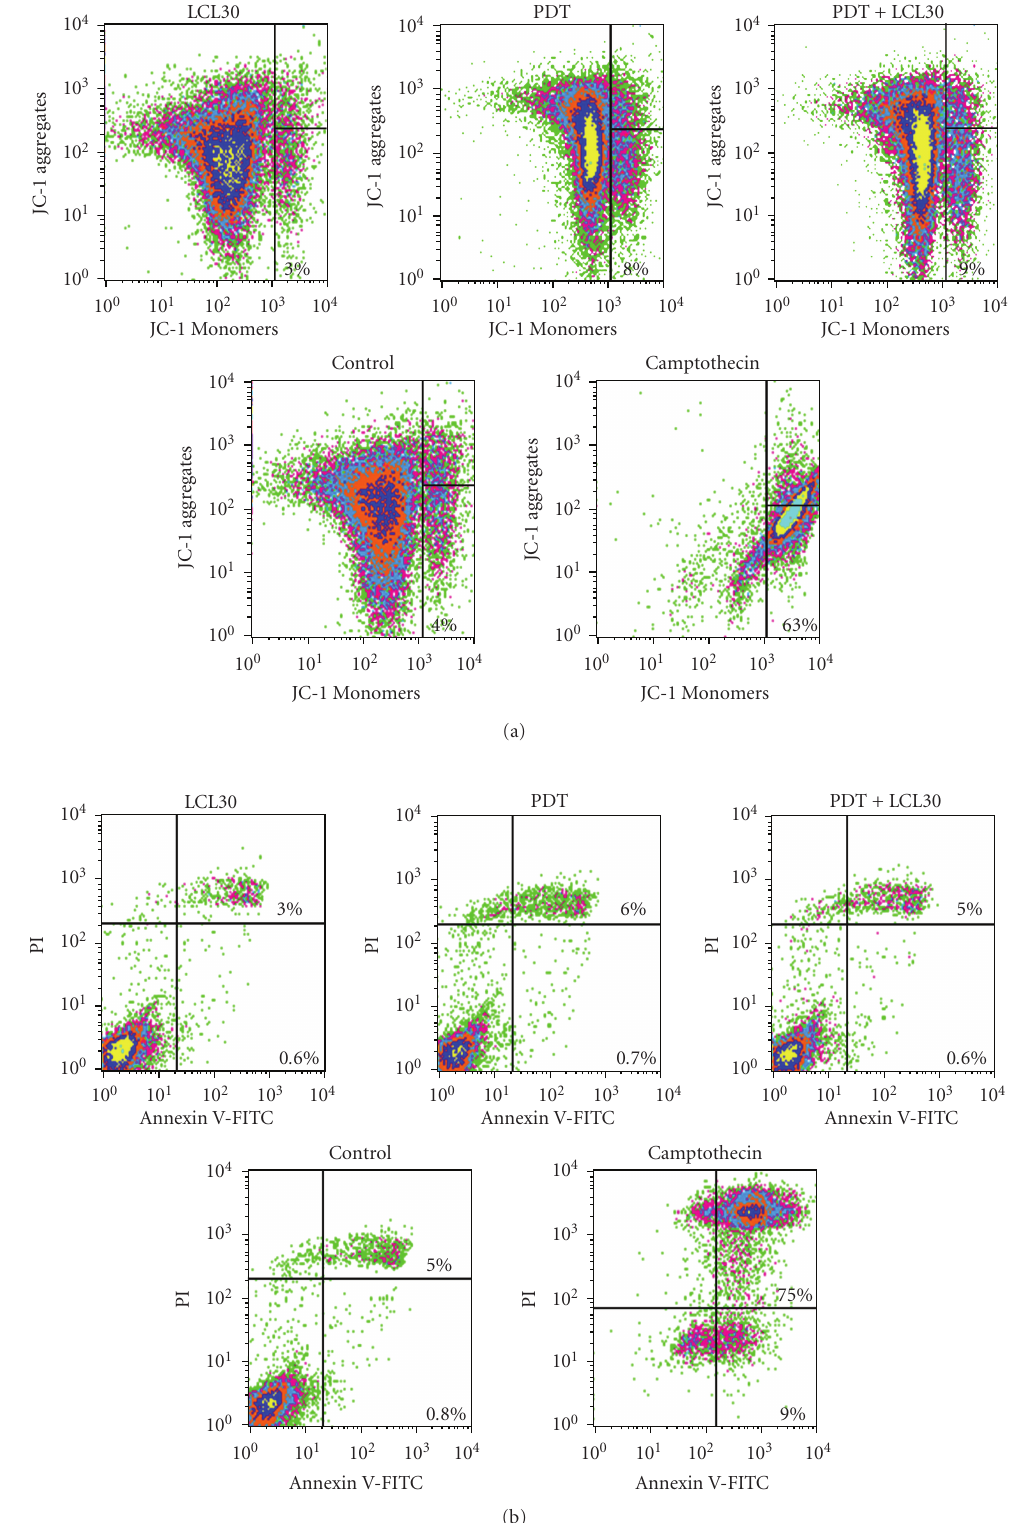
Figure 4: PDT, with or without LCL30, has no e ff ect on mitochondrial membrane potential or apoptosis. Following incubations, cells were collected and processed for flow cytometry. JC-1 and Annexin V/PI staining were used to detect mitochondrial membrane potential (a) and apoptosis (b), respectively. See Section 2 for other details. (a) Percentage of cells with depolarized mitochondria is shown in lower right dot plot. (b) Percentage of Annexin V (+)/PI ( − ) and Annexin V (+)/PI (+) is shown in lower right and upper right dot plot, respectively. The representative data for PDT, with or without LCL30, from two independent experiments are